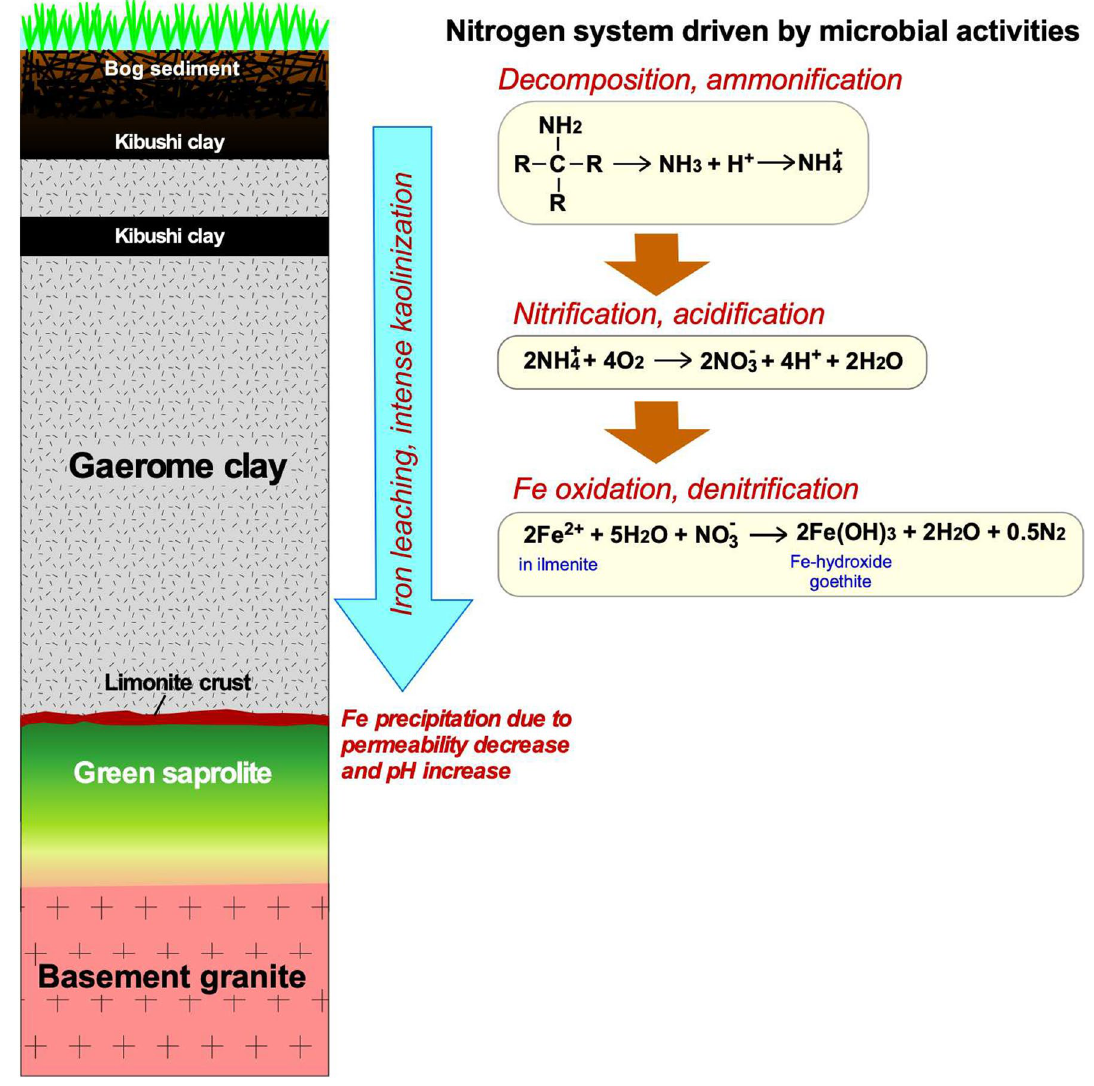
Figure 13. Schematic cross section of Motoyama kaolin deposits showing assumed material flow and chemical 13 C / 12 C − 1 × 1000. / δ 13 C PDB ( ‰ ) = (cid:31)(cid:30) 13 C / 12 C (cid:28) (cid:29) sample (cid:30) (cid:29) PDB Isotopically calibrated acetanilide (δ 13 C = − 28.9 ‰) was used as a working standard. For the N isotope measurement, an amount of sample containing 15 μg of carbon was placed in a tin capsule, and treated in the same way as the C isotope measurements. Each isotope ratio is the mean value of two meas- urements. The isotopic compositions are reported using the delta notation as the per-mil (‰) deviation of the 15 N/ 14 N ratio of the sample relative to that of the atmospheric N 2 using the following equation: Isotopically calibrated acetanilide (δ 15 N = − 0.9 ‰) was used as a working standard. Fe isotope measurements. The Fe isotope compositions were measured using a multi-collector ICP-MS (Neptune Plus, Thermo Scientific) at the Research Institute for Humanity and Nature, Kyoto, Japan. Instru- mental mass bias was corrected using the standard-sample-standard bracketing method 54 . The analyses were performed in middle-resolution mode ( M /Δ M = 8000–9000) in order to eliminate the major isobar interferences of 40 Ar 14 N + , 40 Ar 16 O + and 40 Ar 16 OH + on 54 Fe, 56 Fe and 57 Fe, respectively 54 . The interferences of 54 Cr + on 54 Fe + and 58 Ni + on 58 Fe + were monitored using 52 Cr + and 60 Ni + , and the contributions were corrected using the isotopic abundance ratios of 54 Cr/ 52 Cr = 0.0282 and 58 Ni/ 60 Ni = 2.616 (Ref. 55 ). The isotopic compositions are reported